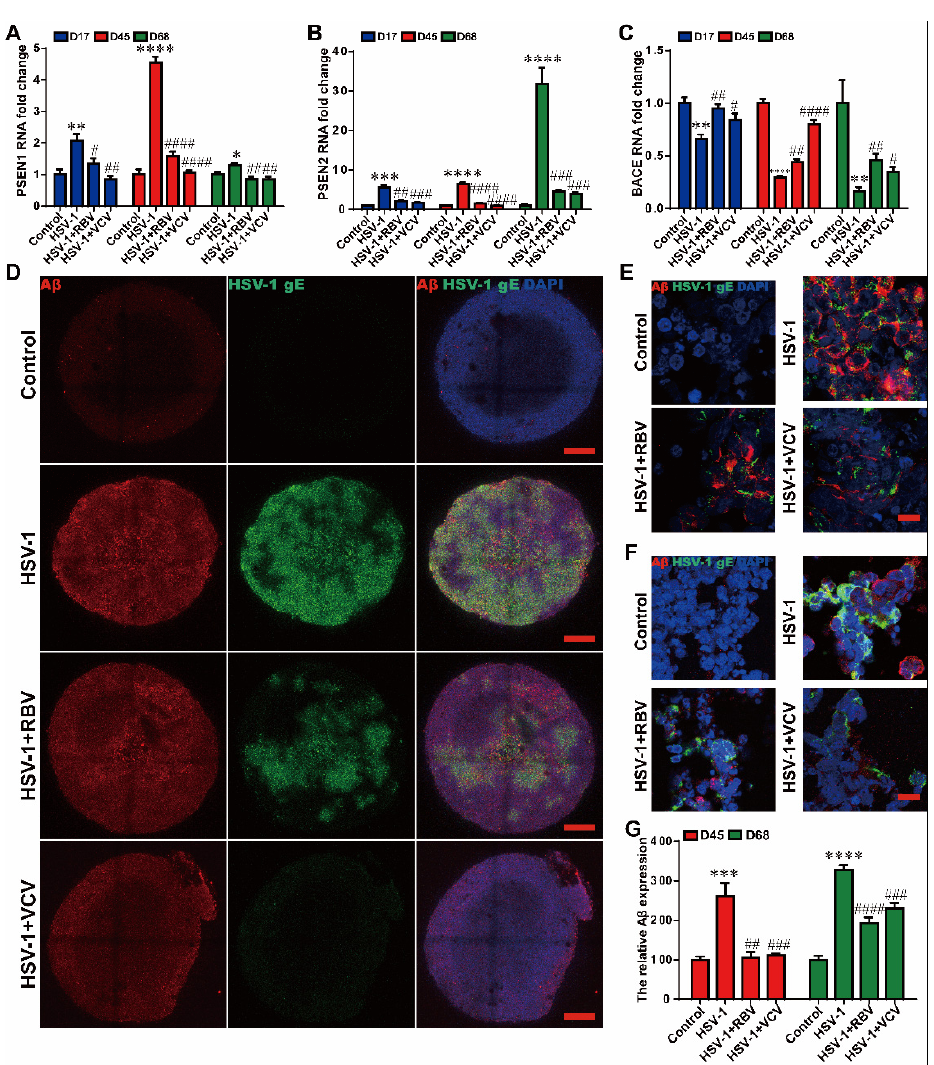
Figure 5. RBV and VCV treatments resulted in decreased A β deposition and normalized AD-mediator expression in the cerebral organoids. ( A – C ) The mRNA expressions of AD mediator genes ( PSEN1 , PSEN2 , and BACE ) were examined by RT-PCR in cerebral organoids in different groups at D14 + 3, D42 + 3 and D65 + 3. ( D ) Whole-mount 3D immunofluorescence imaging of HSV-1 and A β in the HSV-1-infected cerebral organoids treated with RBV or VCV at D14 + 3. Scale bars (red rectangle): 250 µm. ( E , F ) Immunocytochemistry analysis and ( G ) quantification of the HSV-positive and A β -positive cells in the HSV-1 infected cerebral organoids with the RBV or VCV treatment at D42 + 3 and D65 + 3. Scale bars (red rectangle): 100 µm. Data represent the mean ± SEM. * p < 0.05 vs. the control group, ** p < 0.01 vs. the control group, *** p < 0.005 vs. the control group, **** p < 0.001 vs. the control group, # p < 0.05 vs. the HSV-1 infection group, ## p < 0.01 vs. the HSV-1 infection group, ### p < 0.005 vs. the HSV-1 infection group, #### p < 0.001 vs. the HSV-1 infection group, ( n = 6).